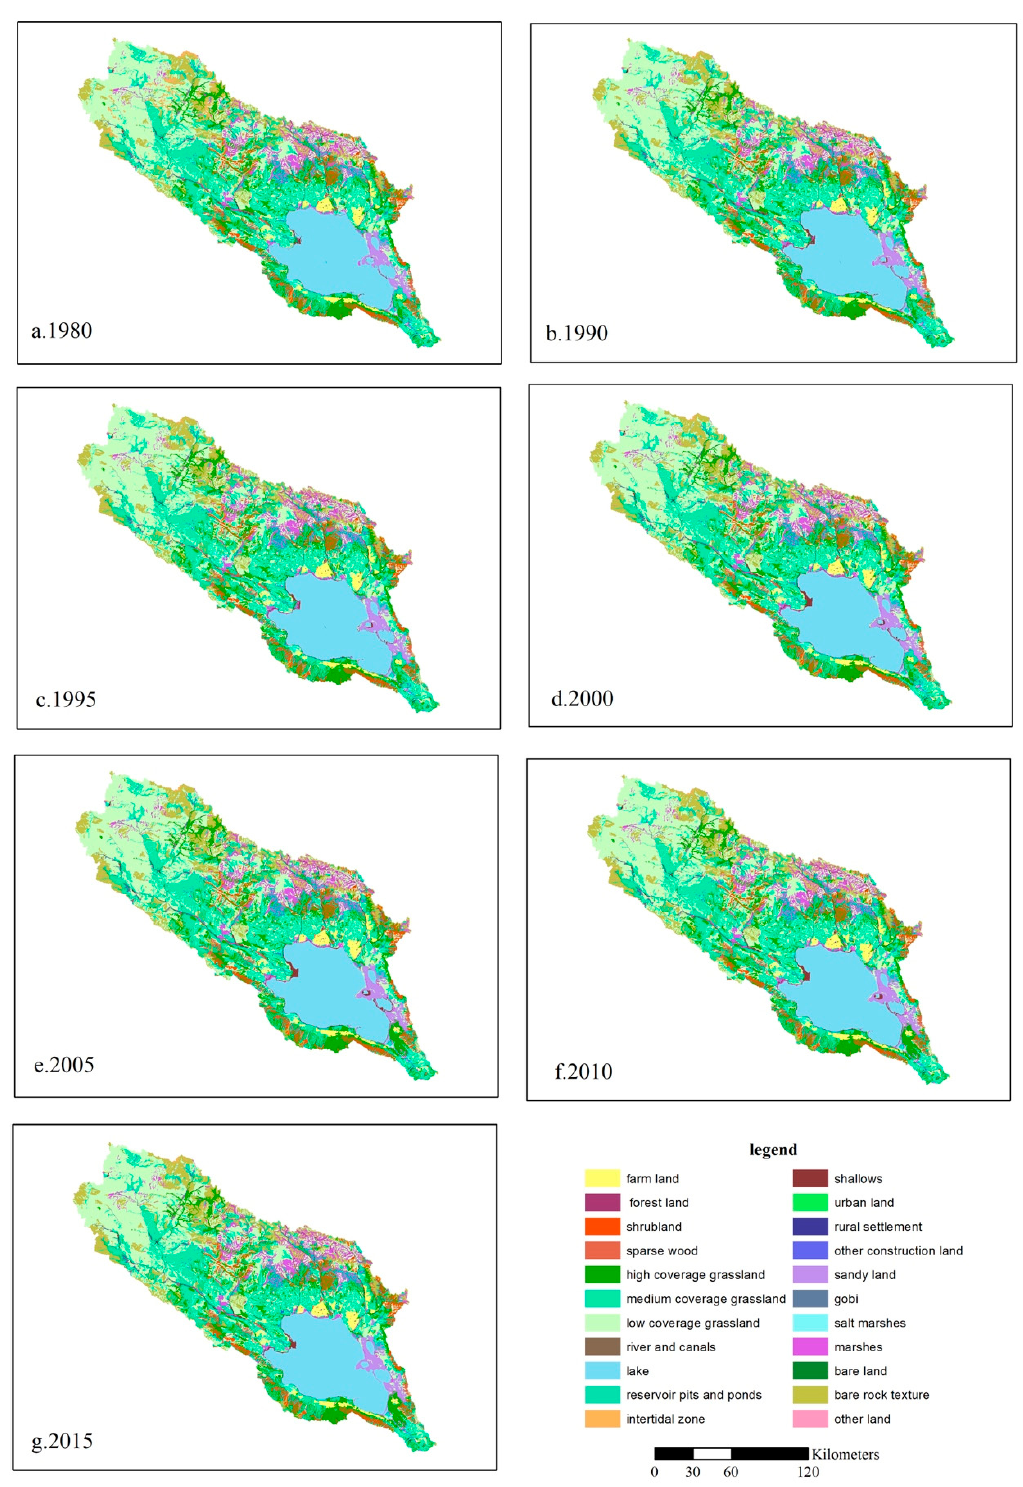
Figure 5. The changes in land use in Qinghai Lake basin from 1980 to 2015.